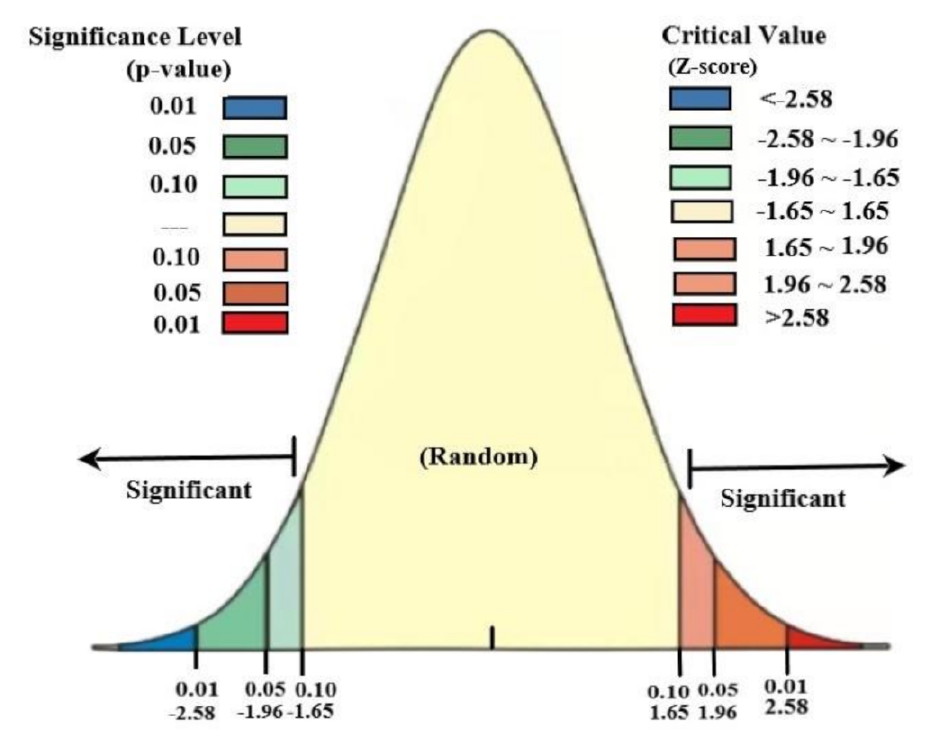
Figure 4. Normal distribution